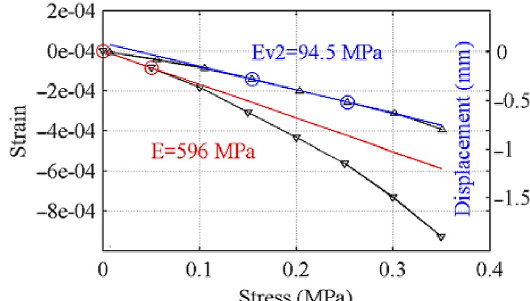
Fig. 2. The modulus of elasticity and the modulus of